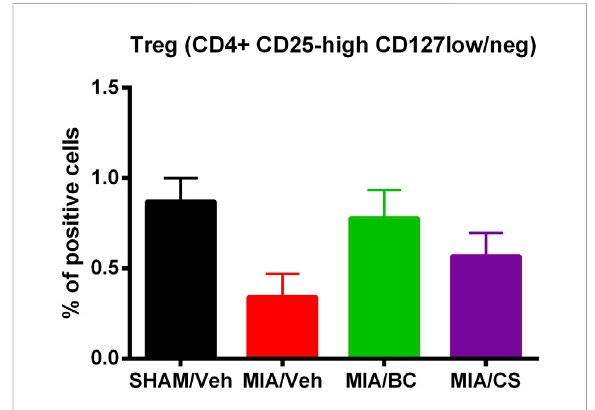
FIGURE 5 Analysis of the percentage of specialized subpopulation of T regulatory cells (Tregs) in sham and MIA-injected mice treated with BC or CS (200 and 400 mg/kg). The panel shows changes in the percentage of T CD4 + lymphocytes expressing CD25- high CD127-low/neg. Values are expressed as mean ± S.E.M. of measurements of at least three independently performed experiments. The two-way ANOVA test was employed, and p < 0.05 was considered statistically signi fi cant.